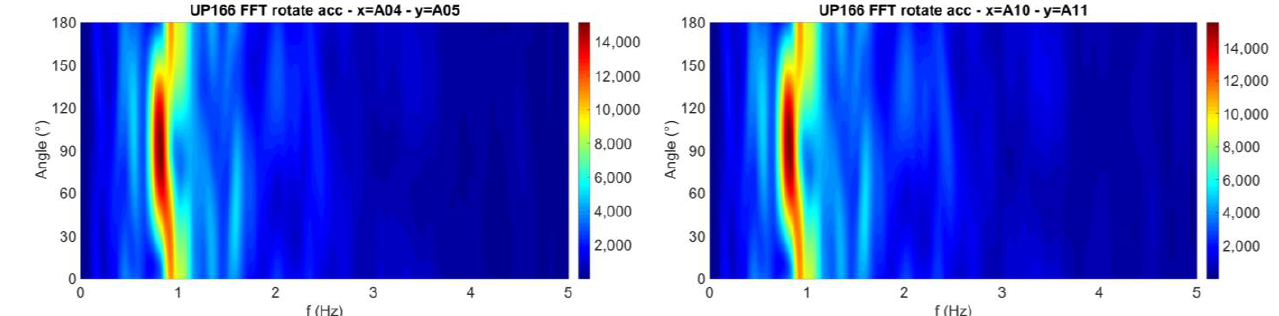
Figure 7. Spectrum rotates of the couples of recordings A04-A05 and A10-A11, obtained during the 30 October 2016 Norcia earthquake.